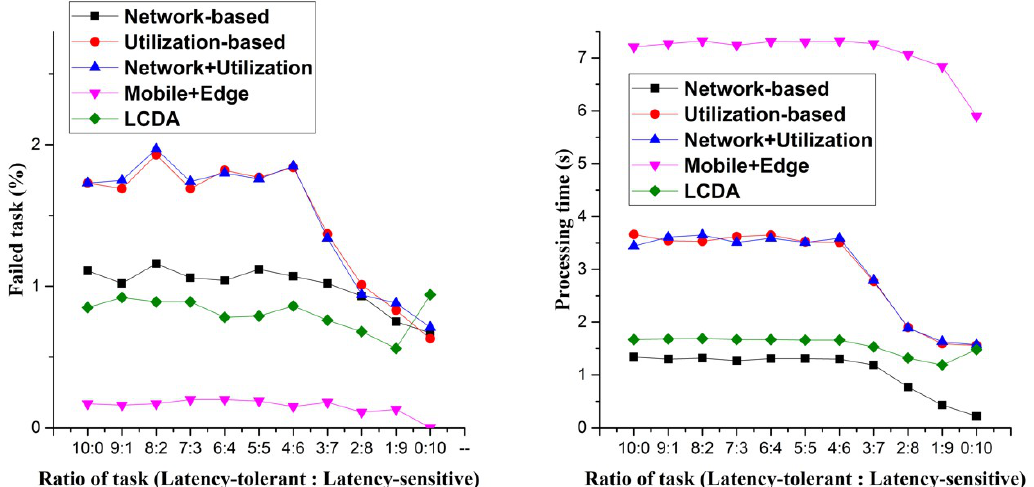
Figure 6. Performance comparison for latency-tolerant to latency-sensitive ratio.